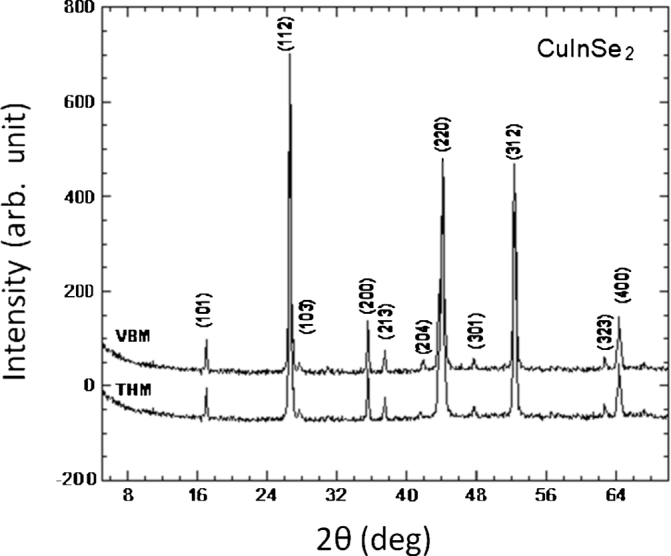
The X-ray diffraction pattern of VBM and THM crystals.